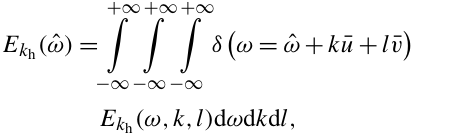
Figure A1. Intrinsic frequency spectra of kinetic energy per unit mass ( E k , solid lines) and rotary ratio (dashed lines) along ERA5 h trajectories starting at Vorcore balloon locations for different reanal- ysis output frequencies: 1, 3 and